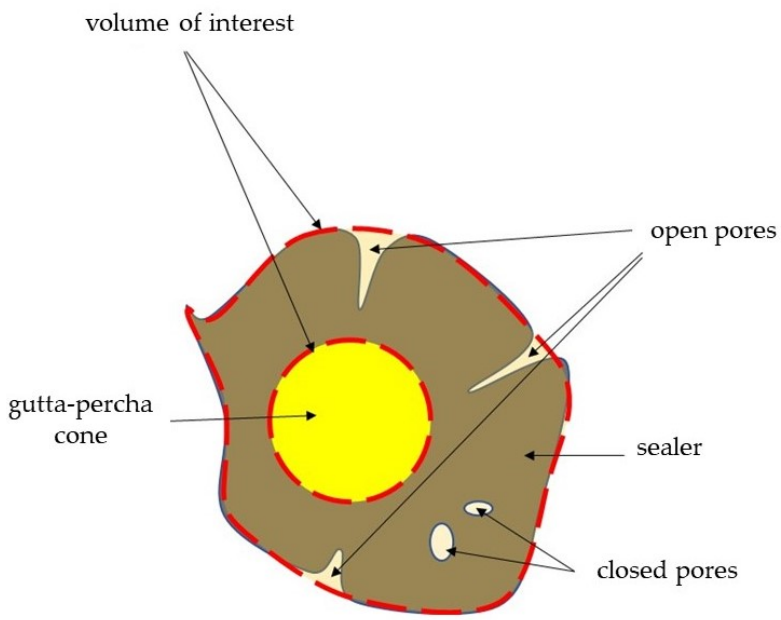
Figure 1. Scheme of volume of interest (VOI) cross-section.